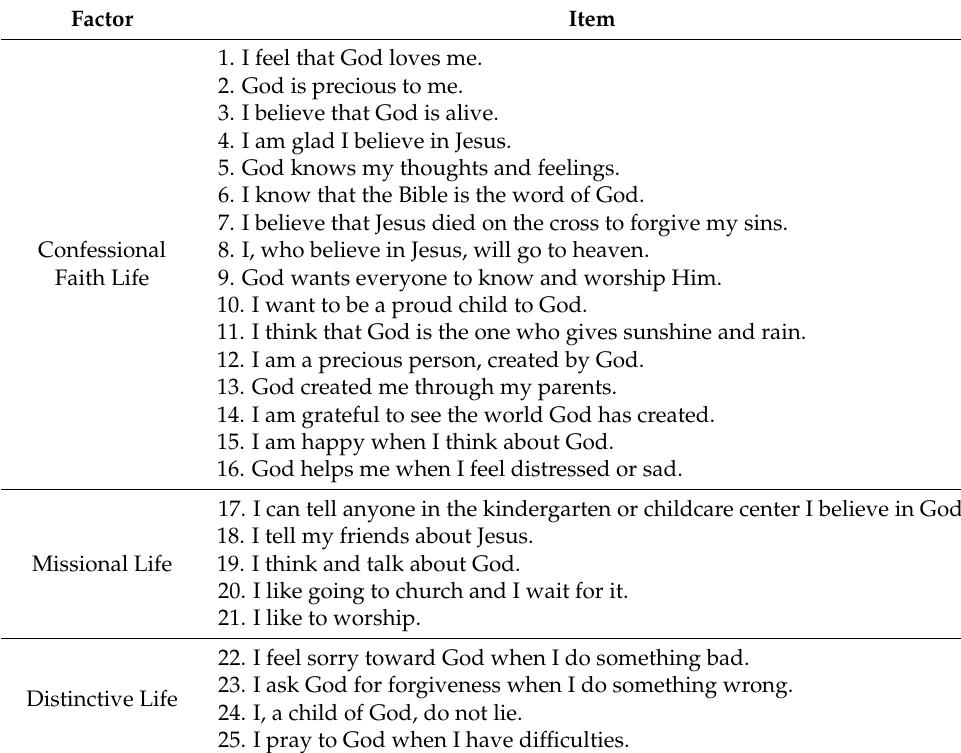
Table 6. Final factor and